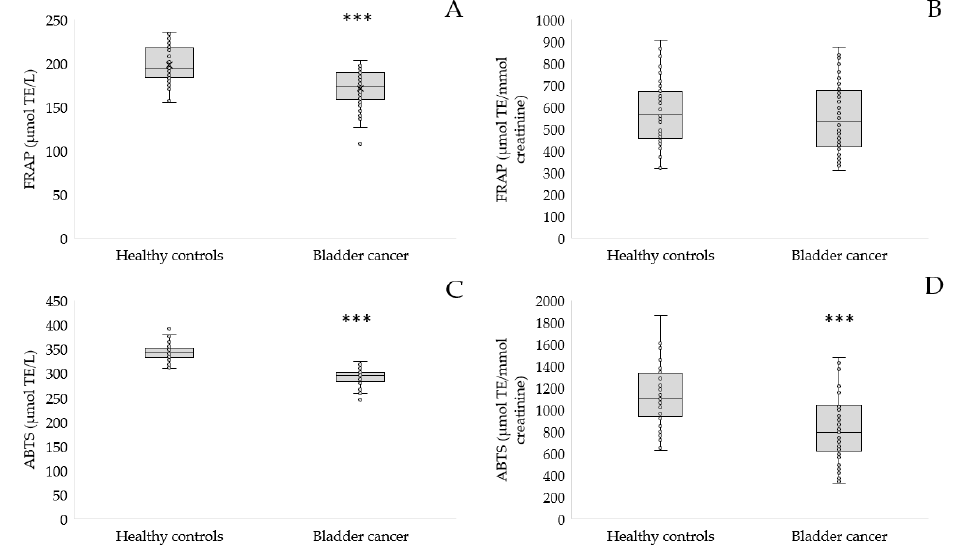
Figure 3. TAC measured with FRAP in serum ( A ), urine ( B ) and TAC measured with ABTS • in serum ( C ), urine ( D ) of patients with bladder cancer in comparison to the controls; *** p < 0.001.